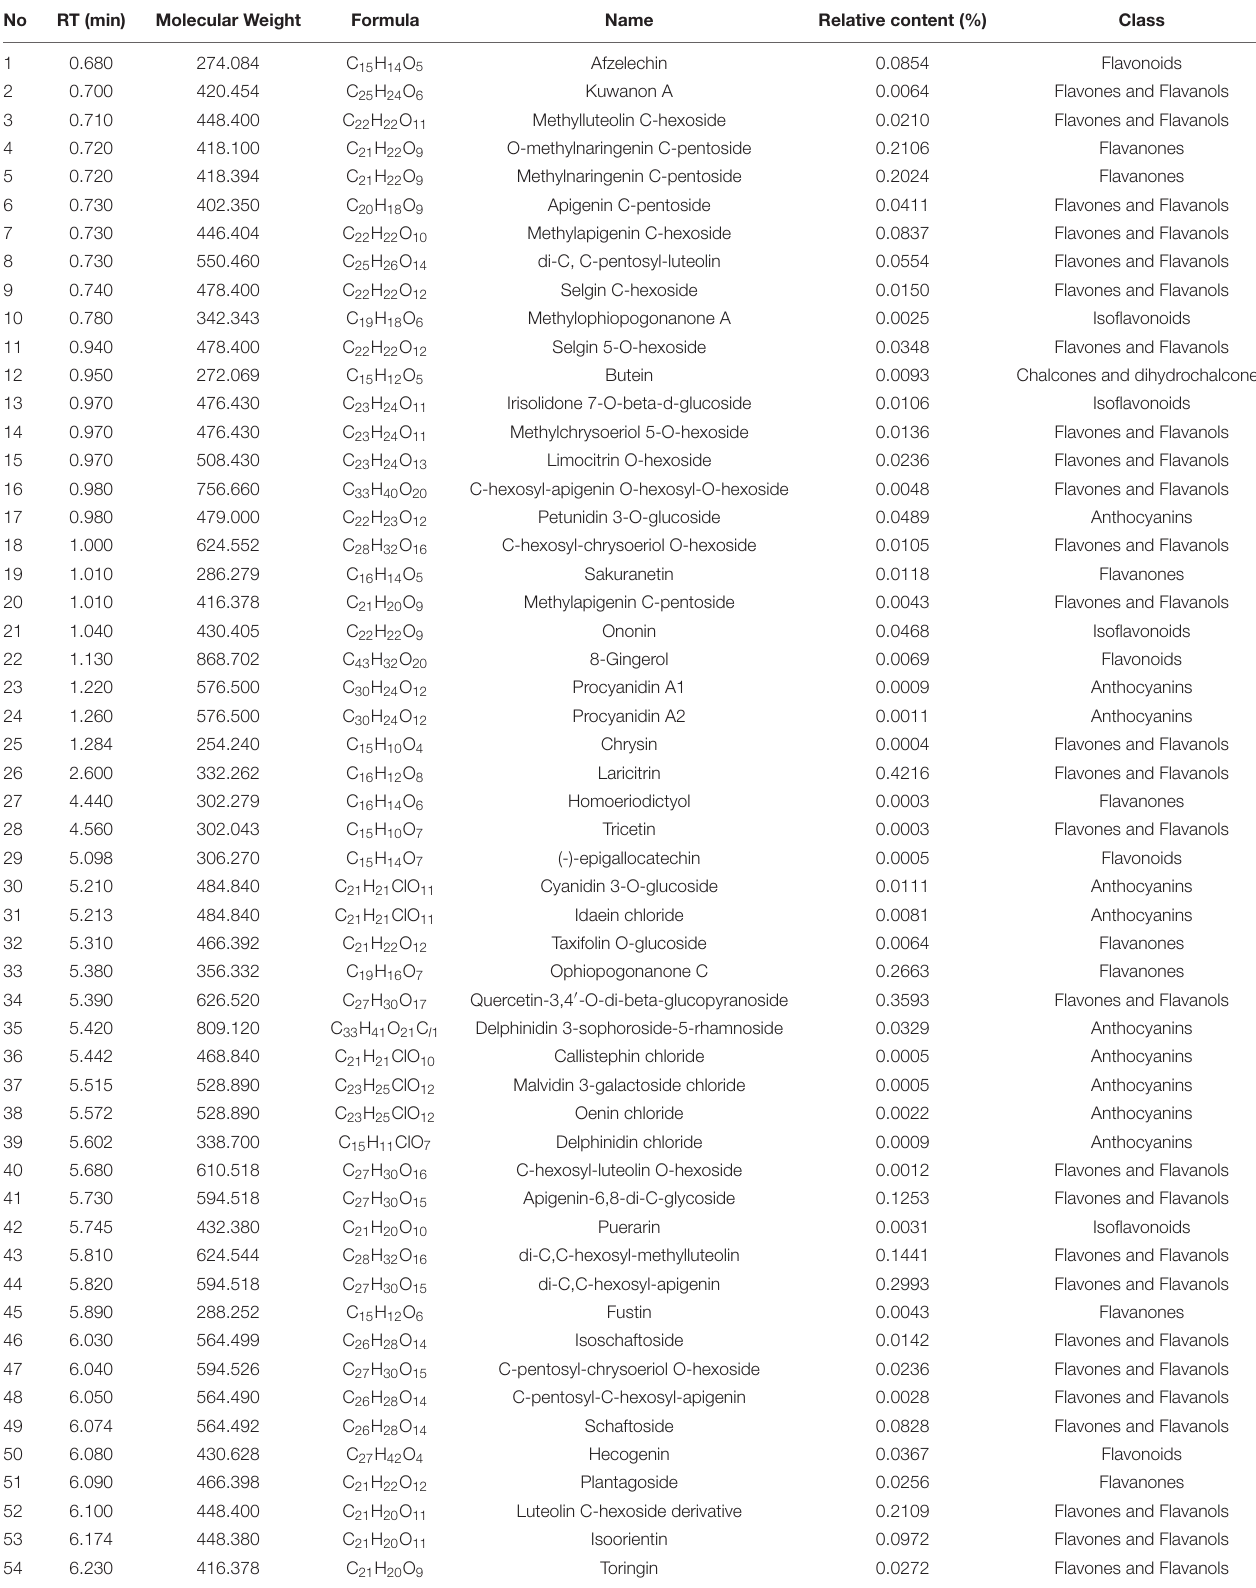
TABLE 2 | Flavonoids compounds identified in EUMF by